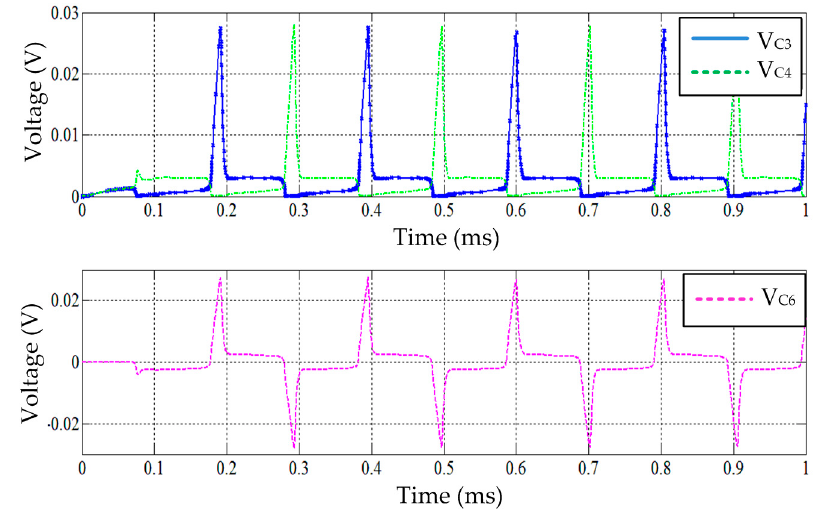
Figure 9. The signals at V C 3 , V C 4 and V C 6 for an input signal of V ac = 3 mV and frequency of 2.45